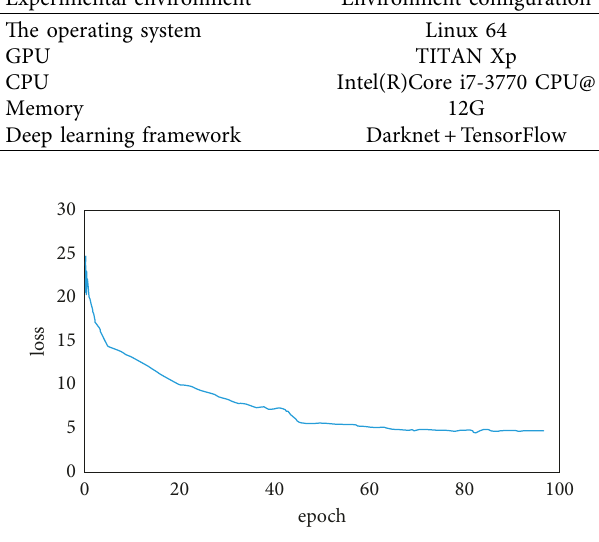
Figure 6: Graph of average loss